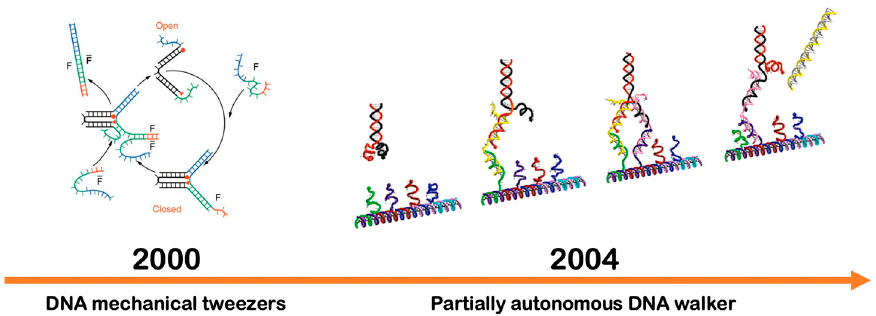
Figure 5. Dynamic DNA systems with capabilities to exhibit complex and controllable motions at the molecular scale. A schematic representation of programmable DNA tweezers shows its operations that can open and close repeatedly. Adopted with permission from [110]. Copyright 2000, Springer Nature. Utilizing the cascade DNA hybridization reaction, a programmable DNA walker can traverse along a predetermined DNA track. Adapted with permission from [120]. Copyright 2004, American Chemical Society.